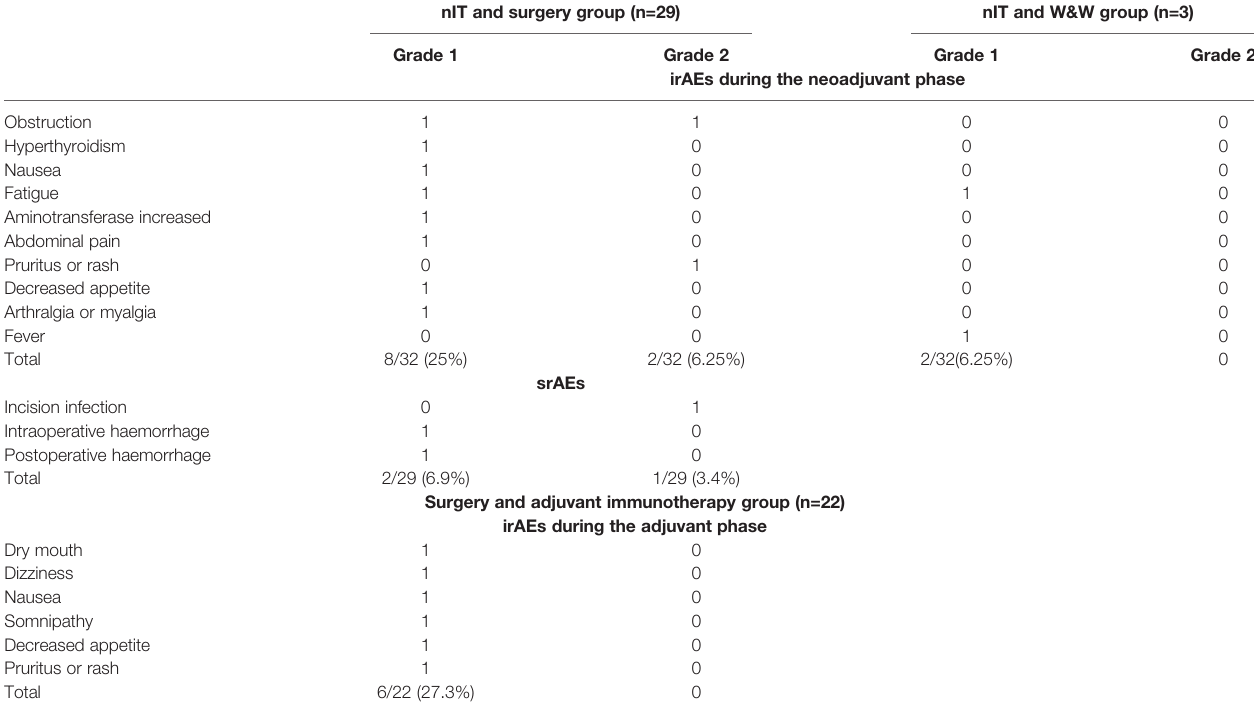
TABLE 3 | Immune-related adverse events (irAEs) and surgical-related adverse events (srAEs). nIT and surgery group